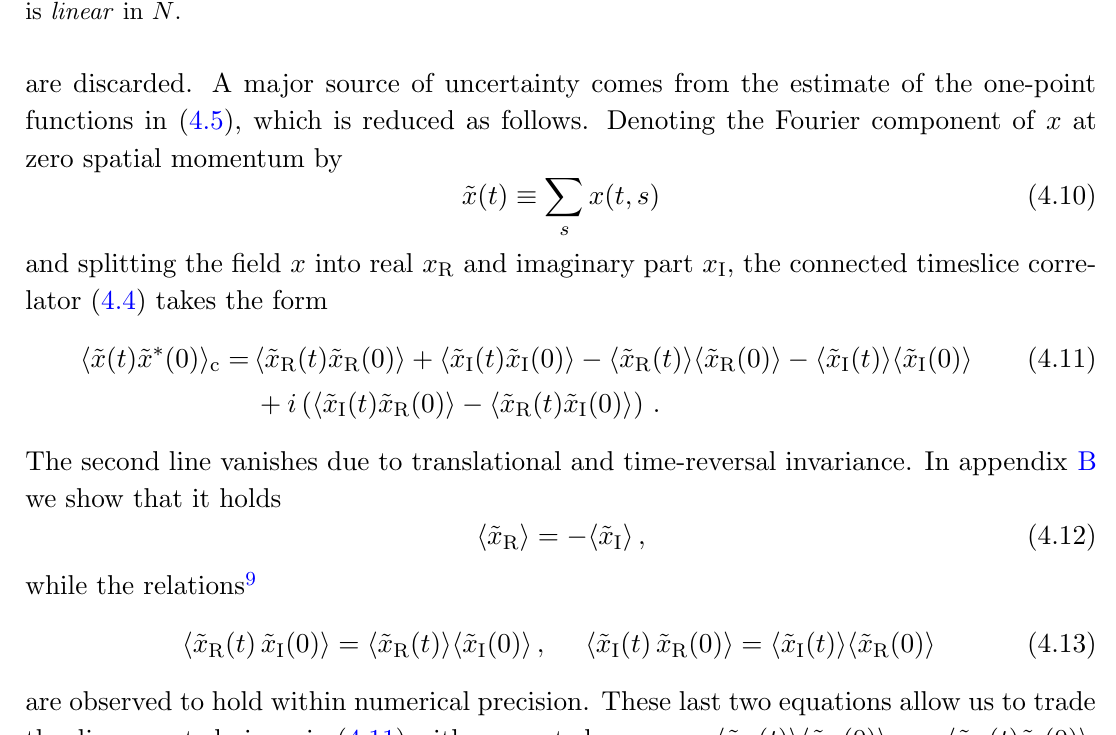
x for several values of g and N . The vacuum h i x a divergence which h i